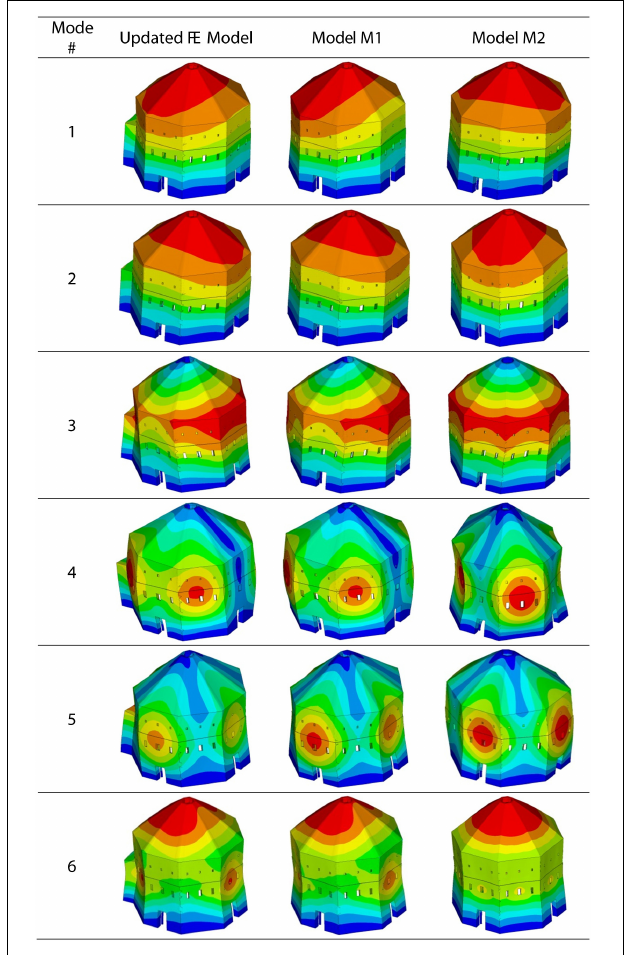
FIGURE 7 | Axonometric view of the first six mode shapes of different models (first column: updated FE Model; second column: model M1; third column: model